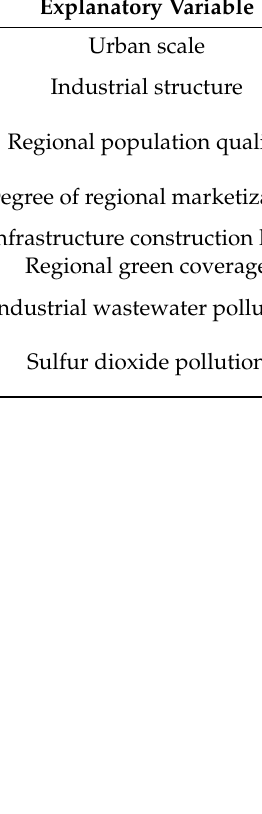
Table 4. Statistics of ECILUs from 2007 to